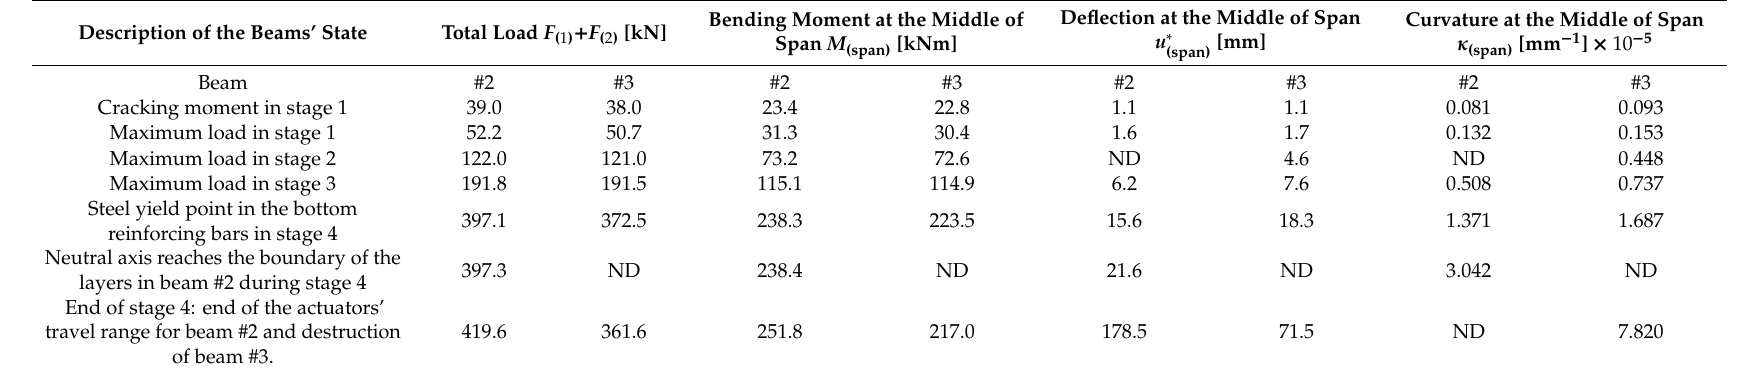
Table 6. Total load, bending moment, deflection, and curvature for the selected states of beams #2 and